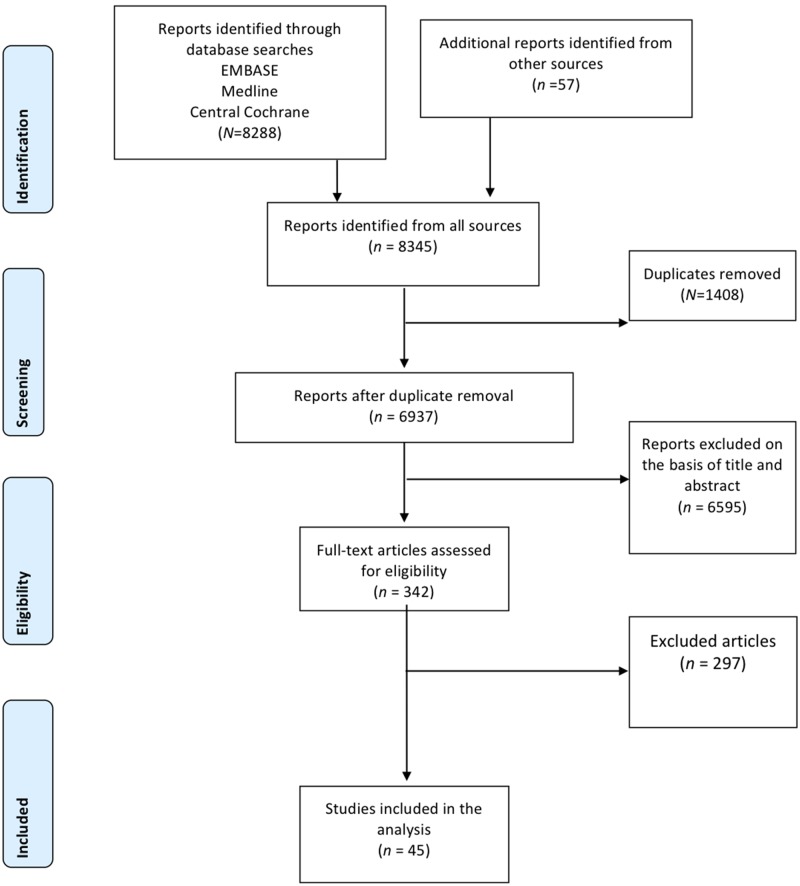
Flow-chart for study selection.